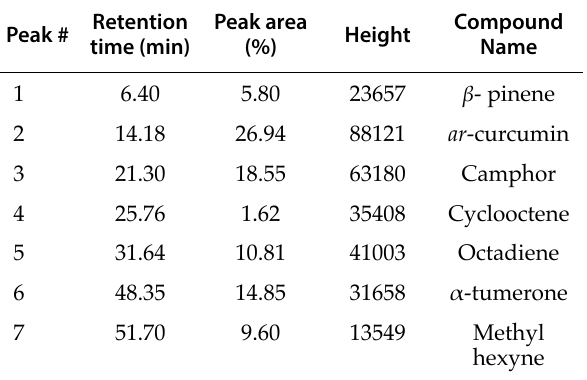
Table 2. Chemical constituents of aqueous extract from tur- meric